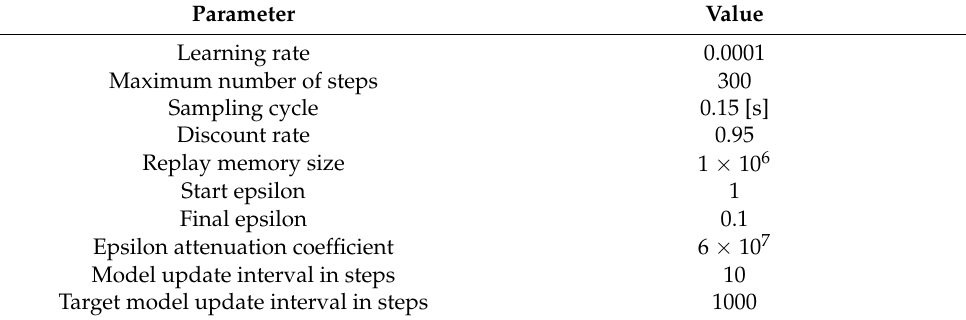
Table 4. Learning parameter settings.